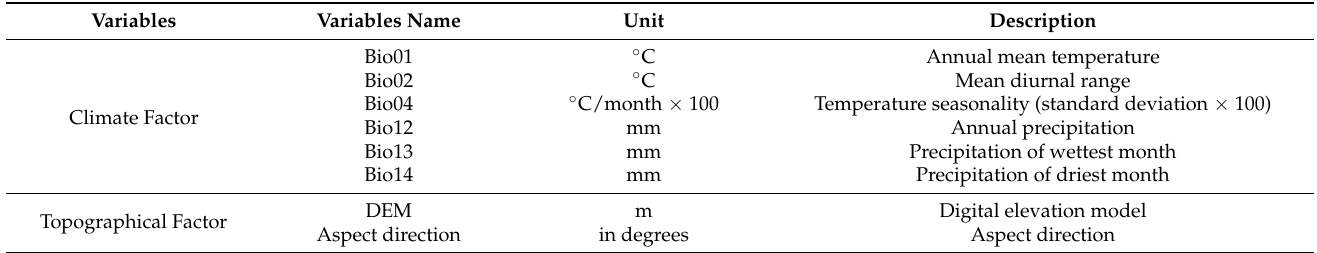
Table 2. Description of environmental variables used for the prediction of suitable